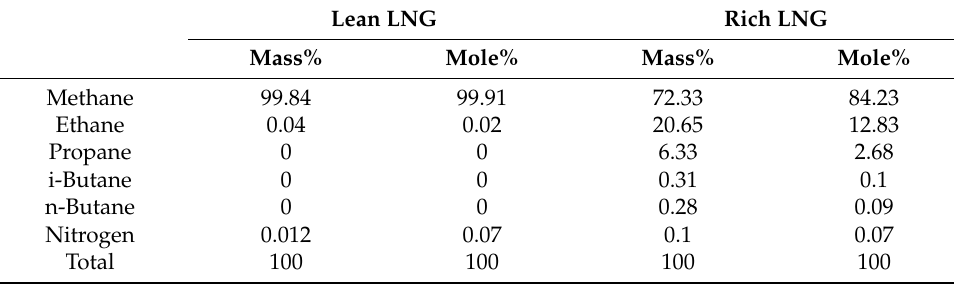
Table 3. Compositions of different types of LNG.